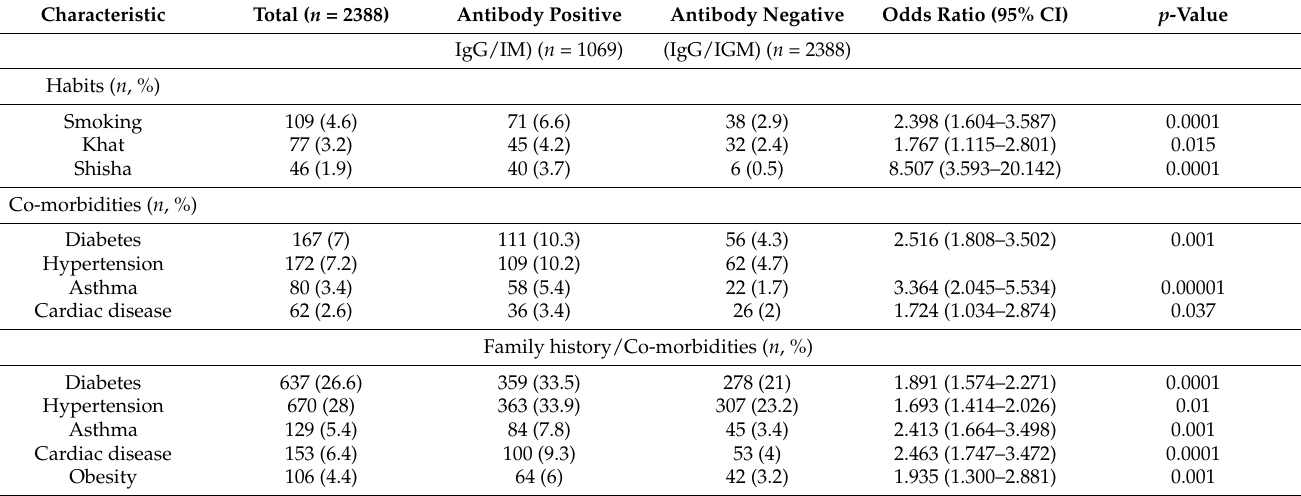
Table 2. Habits, Co-morbidities, Family history of chronic disease and COVID-19